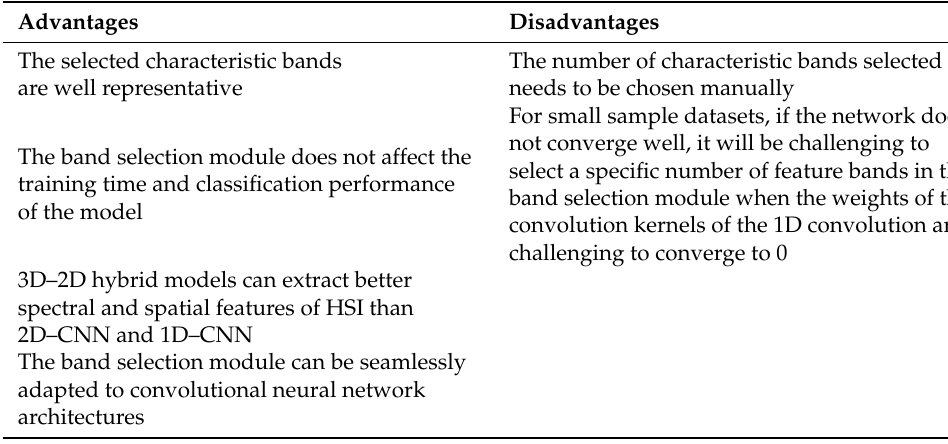
Table 4. Advantages and disadvantages of